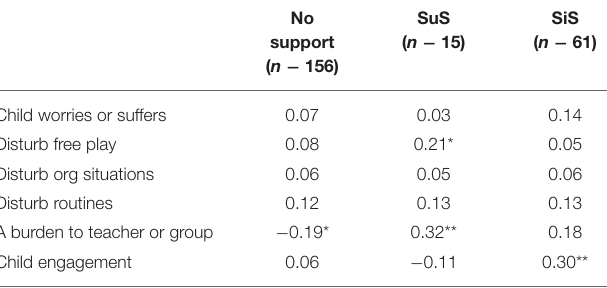
TABLE 4 | Pearson correlations between support format, impact supplement variables, and engagement.